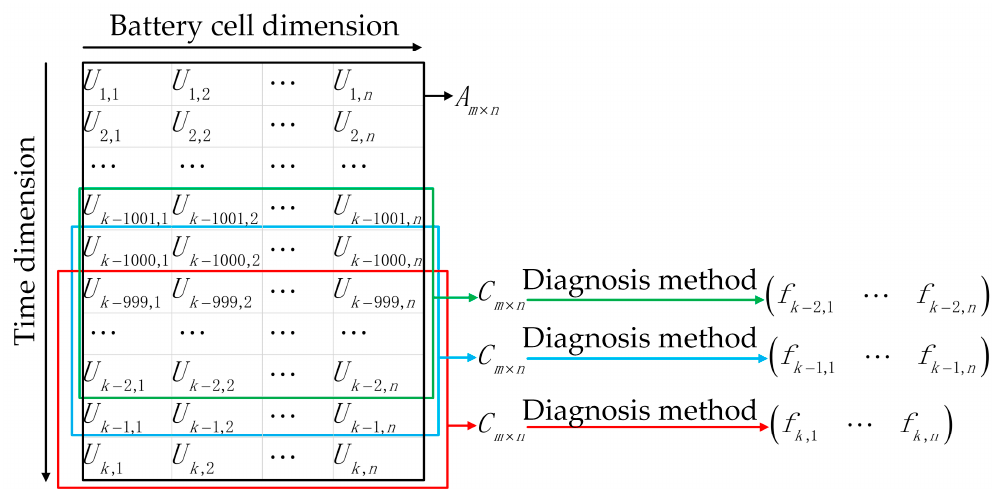
Figure 3. The relationship between C m × n and A